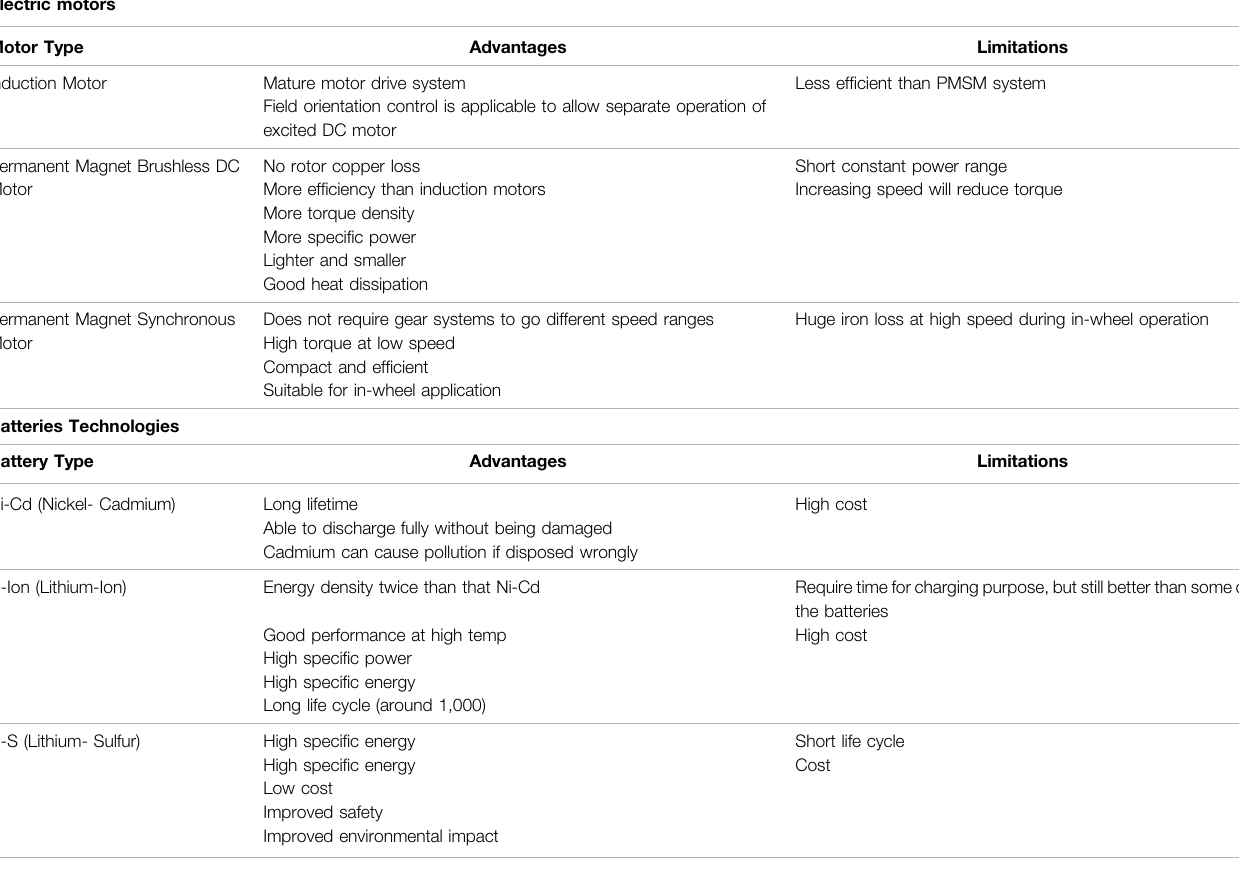
TABLE 7 | Limitations and advantages of different electric motors and batteries technologies (Edwards and Kinney, 2011; Cooper and Moseley, 2013; Chalk and Miller, 2014; Fetcenko et al., 2014; Khaligh and Li, 2014; Olson and Sexton, 2015).